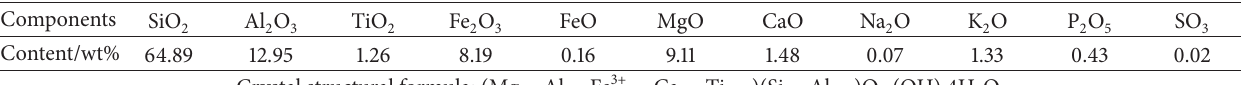
O P O SO 2 2 5 3